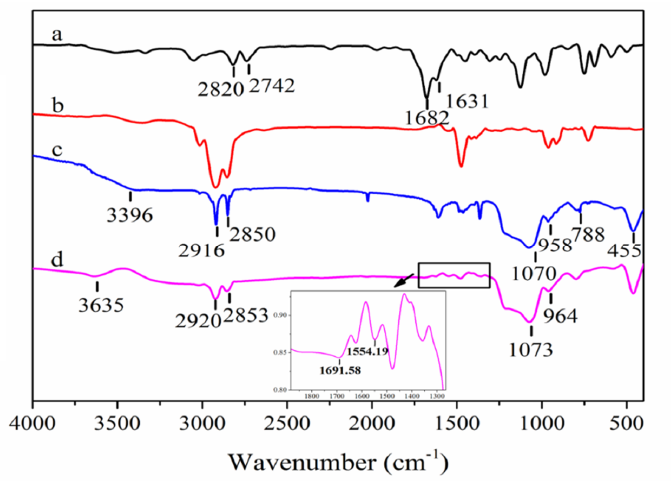
Figure 3. Infrared spectrum ( a ), CA, ( b ), Cetyl- trimethyl ammonium bromide (CTAB) surfactant, ( c ), blank nanoparticle, and ( d ), SiO 2 -CA.